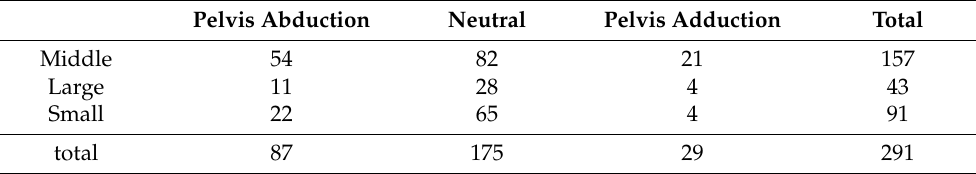
Table 11. Pelvis abduction/adduction (X 2 = 10.75, df = 4, p -value =